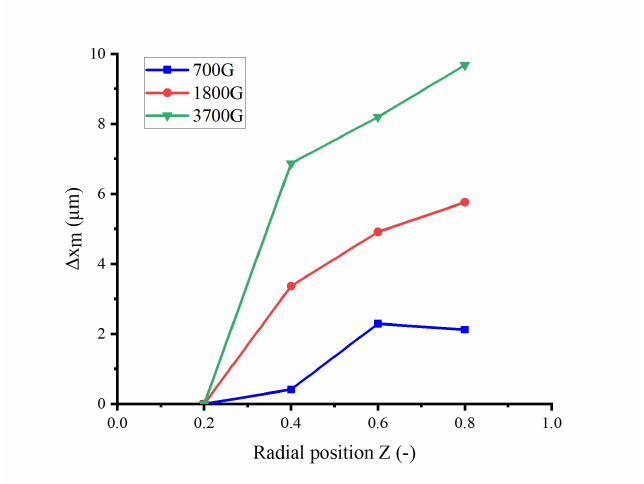
Figure 8. Difference in median particle diameter ∆ x m versus radial